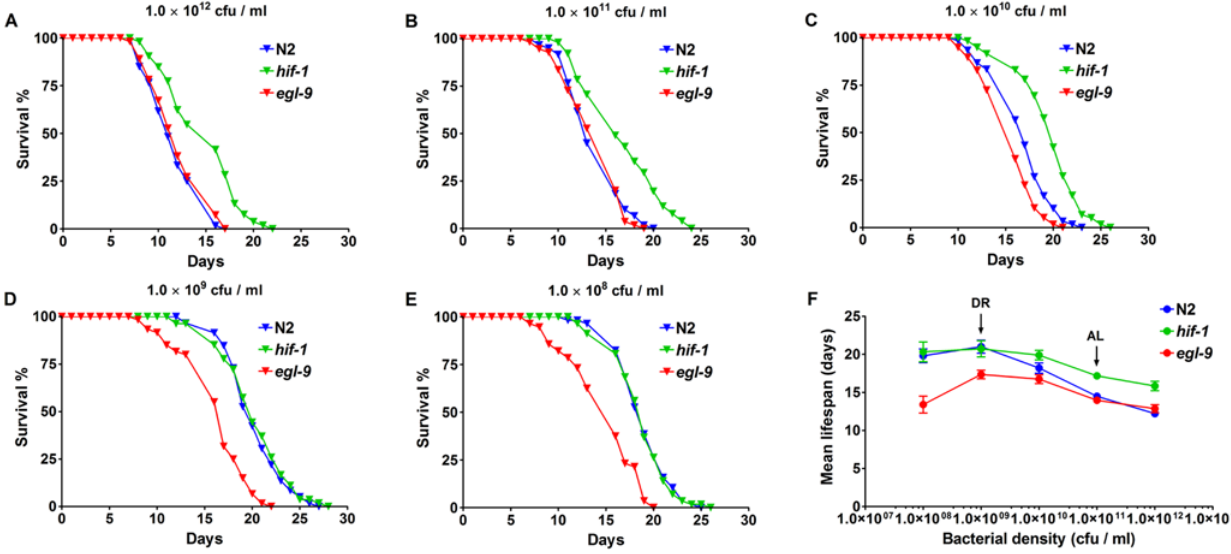
Figure 3. HIF-1 modulates lifespan extension by DR. (A–E) Survival curves and (F) mean lifespan of N2, hif-1 and egl-9 animals fed with E. coli at different concentrations (1.0 6 10 8 to 1.0 6 10 12 cfu/ml) during adulthood. The hif-1 mutant shows lifespan extension under AL and higher bacterial concentrations but not under DR. egl-9 animals show diminished lifespan extension under DR, but they show lifespan similar to that of N2 animals under AL conditions. Each of the lifespan experiments was performed three times with consistent results. Quantitative data and statistical analyses for the experiments shown here and the repeated experiments are included in Table 2 and Table S2, respectively.